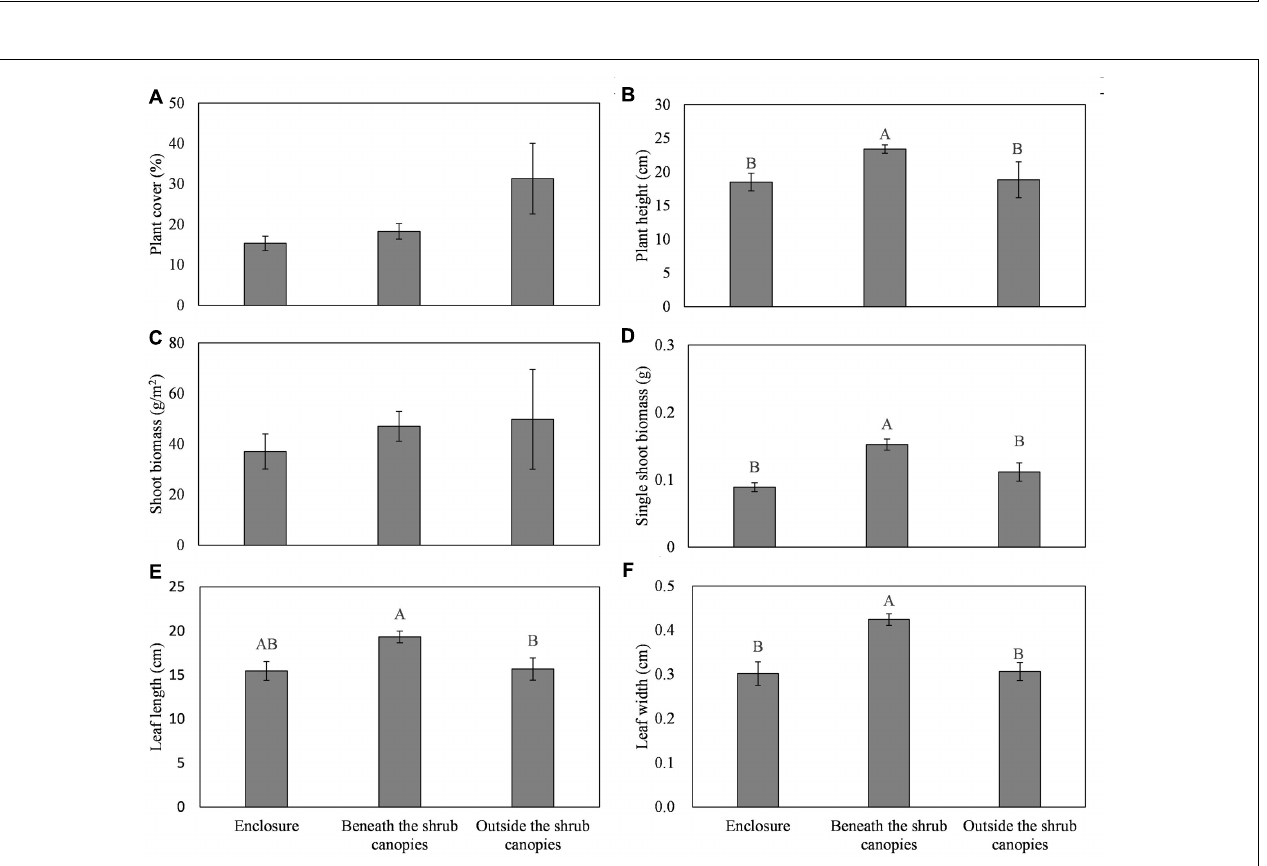
FIGURE 2 | Effects of the sampling sites (enclosure, beneath the shrub canopies, and outside the shrub canopies) on the plant cover (A) , height (B) , shoot biomass (C) , single shoot biomass (D) , leaf length (E) , and leaf width (F) of the clonal herbaceous plant L. chinensis . Different letters represent significant differences among the three sampling sites, while the same letters and/or no letters indicate no significant differences between any treatments at P < 0.05.